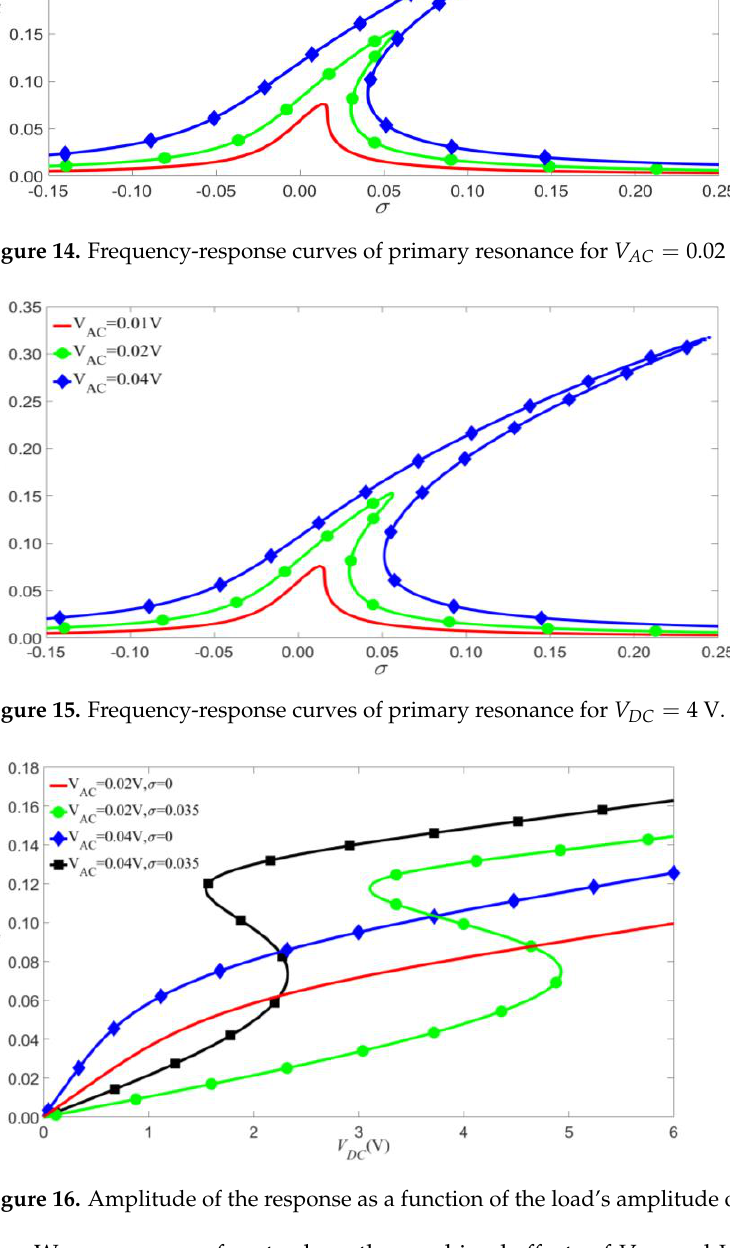
Figure 16. Amplitude of the response as a function of the load’s amplitude of primary resonance.